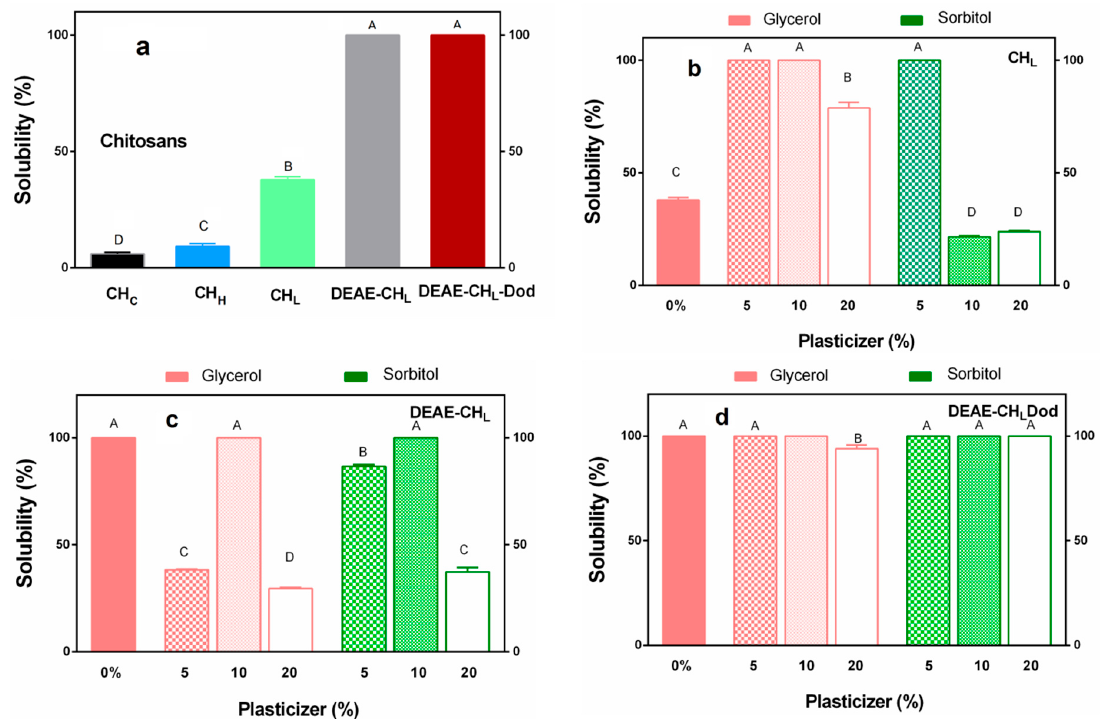
Figure 3. (a) Solubility of chitosan films without plasticizer and prepared with 5%, 10%, and 20% of glycerol and sorbitol for ( b ) CH L ( c ) DEAE-CH L and ( d ) DEAE-CH L -Dod. The values are expressed as means ± SD ( n = 5). Different letters in the same graph indicate a significant difference ( p <0.05). The values are expressed as means ± SD ( n = 3) .